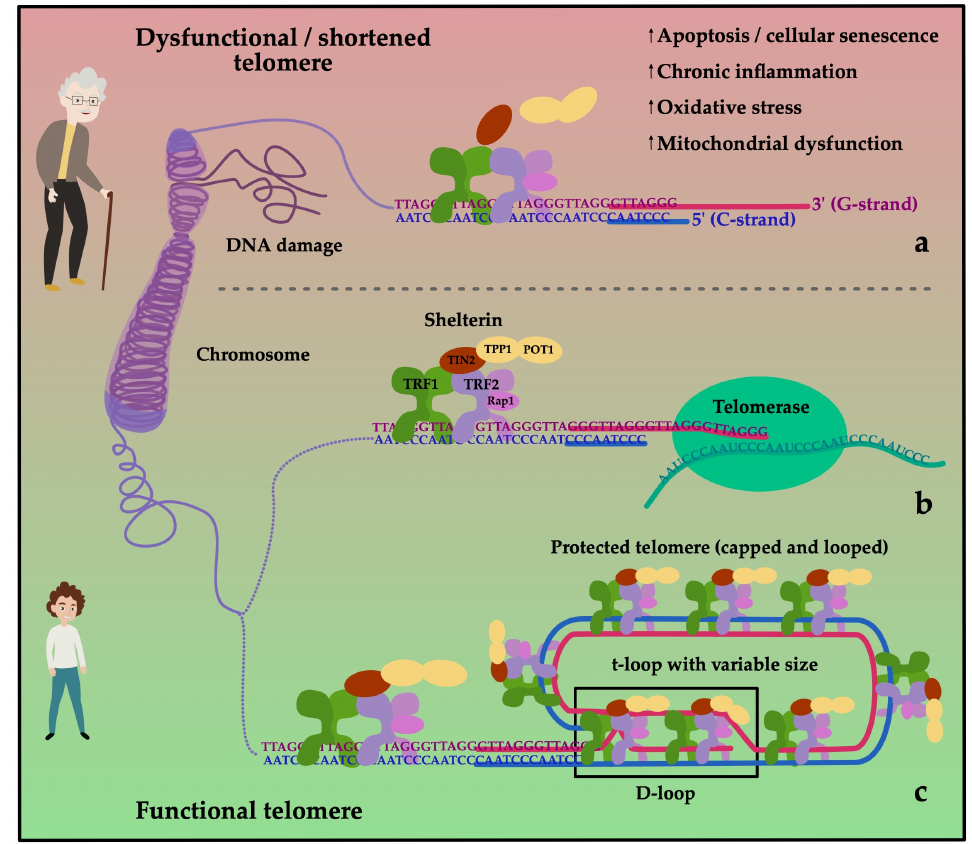
Figure 2. Telomeres act as protective caps at the end of chromosomes. They consist of a sequence of 6 nucleotides (G ‐ strand: 5 ′‐ TTAGGG ‐ 3 ′ ; C ‐ strand: 3 ′‐ AATCCC ‐ 5 ′ ) repeated several thousand times. Telomeres loses length with each cell division. To prevent excessive shortening, they are protected by shelterin. Shelterin is a protein complex consisting of six subunits: telomere repeat binding factor 1 (TRF1), telomere repeat binding factor 2 (TRF2), protection of telomere 1 (POT1), repressor/activator protein 1 (RAP1), TRF1- and TRF2-interacting nuclear protein 2 (TIN2) and tripeptidyl peptidase 1 (TPP1). The 3’ end of the G ‐ rich strand extends over the end of the C ‐ rich strand (5’ end) of the telomere. Given sufficient length of the telomere, this forms the t ‐ loop, which overlaps with the double ‐ stranded 5’ end, building the D ‐ loop protecting the telomeres ( c ). During replication, the G ‐ and C ‐ strands are open. Telomerase can bind to the G ‐ strand to add telomeric repeats preventing the cell from damage ( b ). Loss of function and degradation of the shelterin complex leading to DNA damage occur more frequently during aging and cause the cell to stop dividing ( a ).